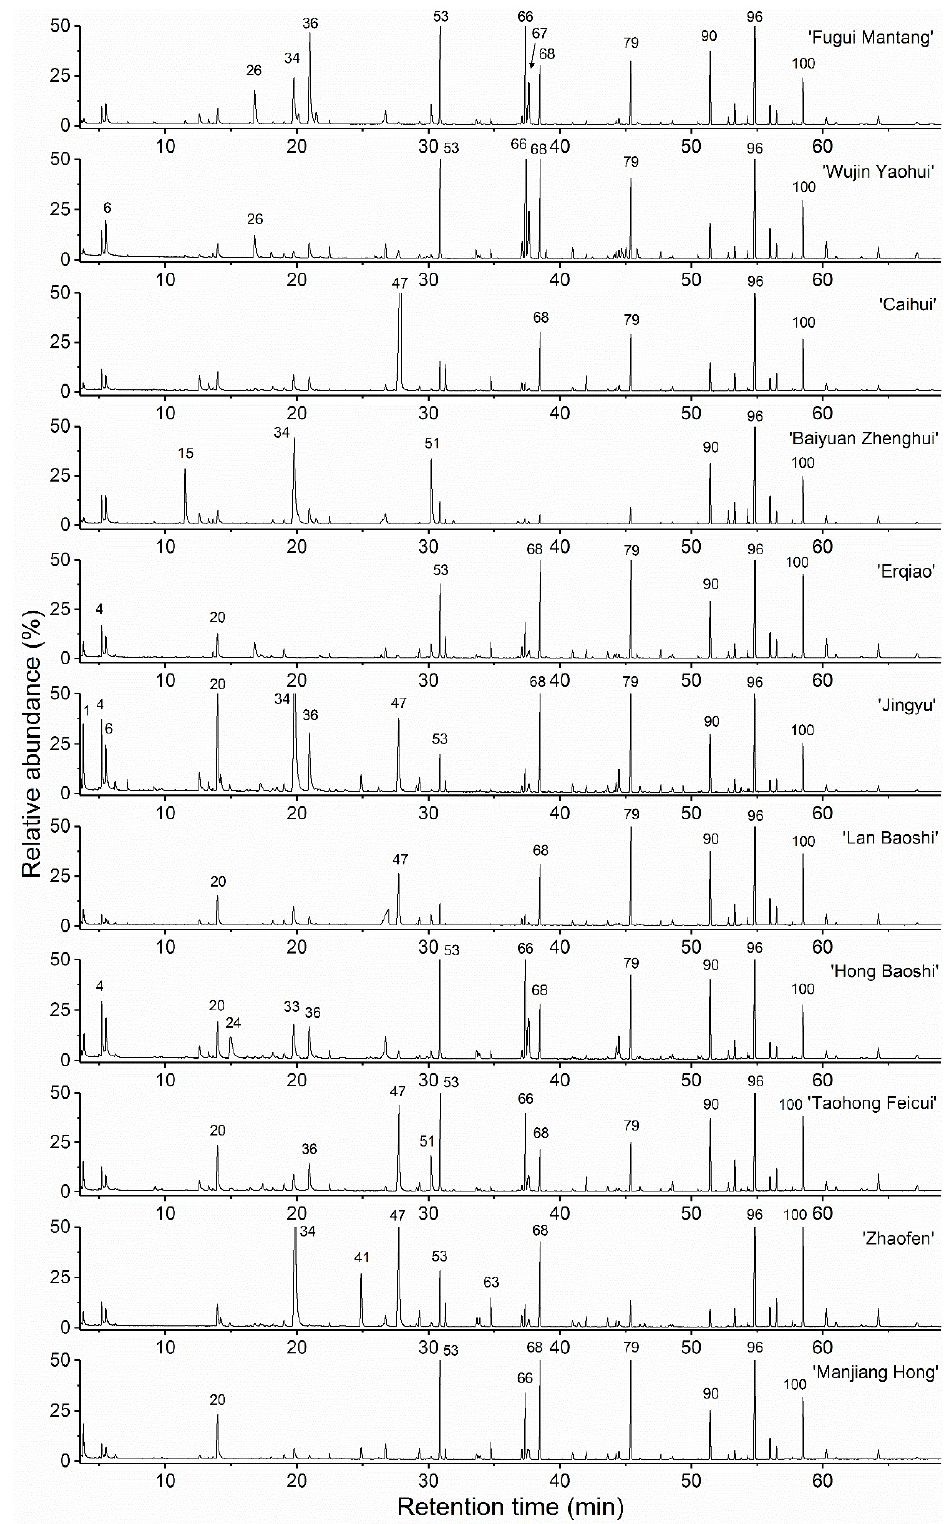
Figure 2. Typical gas chromatograms of flower essential oils of the eleven woody peony cultivars ( Paeonia × suffruticosa Andr.). The main chromatographic peaks are noted with numbers. The num- bering of essential oil components is specified in Table 2. Their identification was based on mass spectra and retention indices.